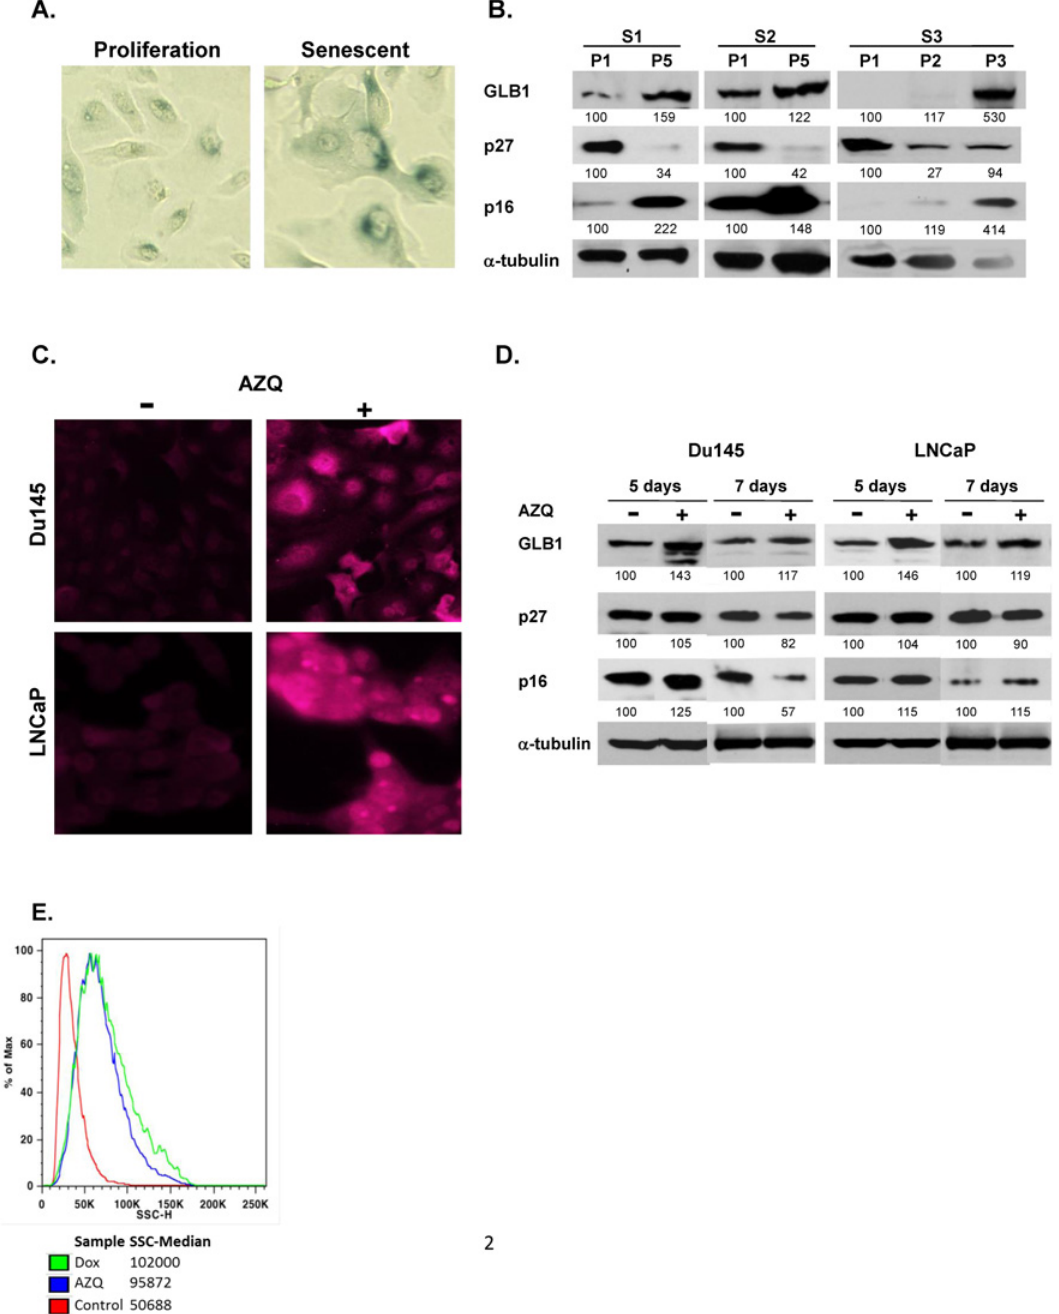
Fig 2. GLB1 is increased in replicative and therapy-induced senescent (TIS) cell culture models. (A) Human prostate epithelial cells were cultured to senescence by repeated cell passaging demonstrate an enlarged, more complex senescent cell morphology and increased β – gal staining in passage 5 (P5) than in proliferating (P1) cultures. (B) Western blot comparing proliferating HPECs (P1) versus later passages (P5) for separate cultures (S1, S2, S3) are shown. GLB1 and p16 expression is increased in senescence. Cultures contained > 50% senescent cells by SA- β gal staining. Images were normalized to α - tubulin. (C) GLB1 mmunofluorescence increases in cancer cells displaying TIS. Du145 and LNCaP cells were treated with 250nM AZQ or DMSO (control) for 3 days, kept in drug-free media for an additional two days, then stained with mouse anti-human GLB1 antibody and detected with anti-mouse-Alexa 647. (D) Western blot analysis of GLB1 expression at 5 or 7 days after AZQ treatment performed in DU145 and LNCaP PCa lines. Cells were compared against a DMSO-treated control group (Con) and normalized to α -tubulin expression levels. (E) Cell granularity and complexity analysis of senescence by flow cytometry. Du145 cells were treated with AZQ or Doxorubicin for 3 days, kept in drug-free media for two days then collected and applied to MACSQuant flow cytometer immediately. Side scatter (SSC), which increases in senescent cells, increased in senescent AZQ and Doxorubicin treated cells compared to control.